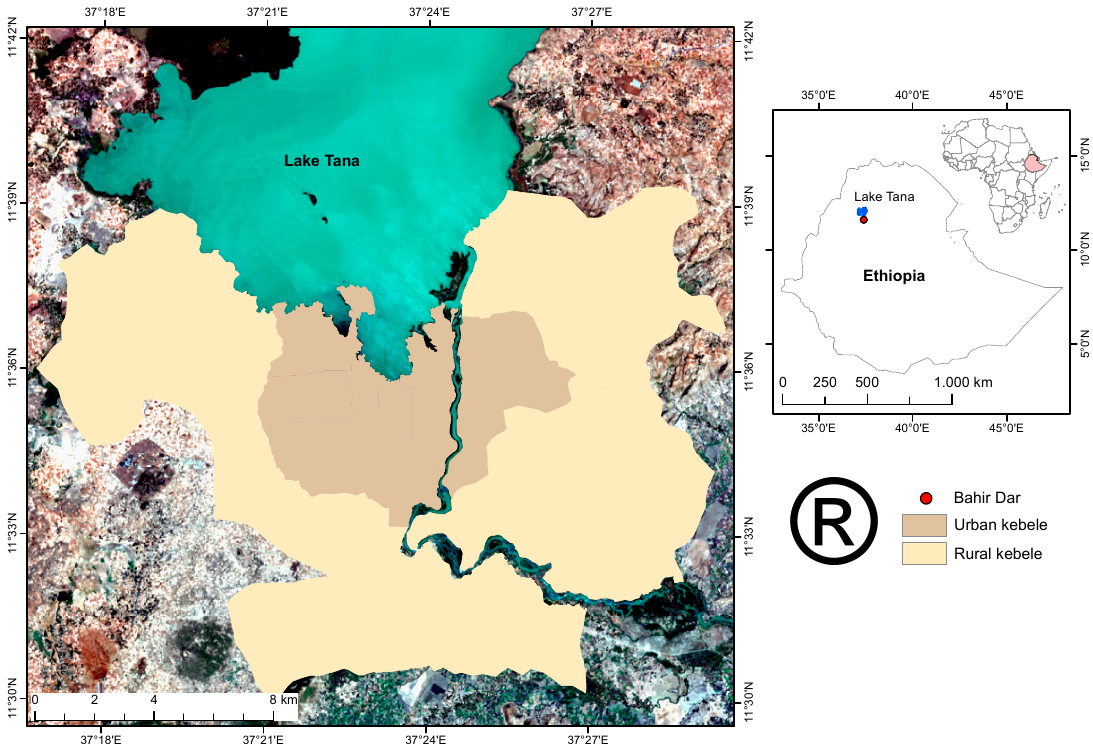
Figure 1. Location of the study area. Background is a Landsat 8 OLI image from 2015 with RGB (red, green, blue).